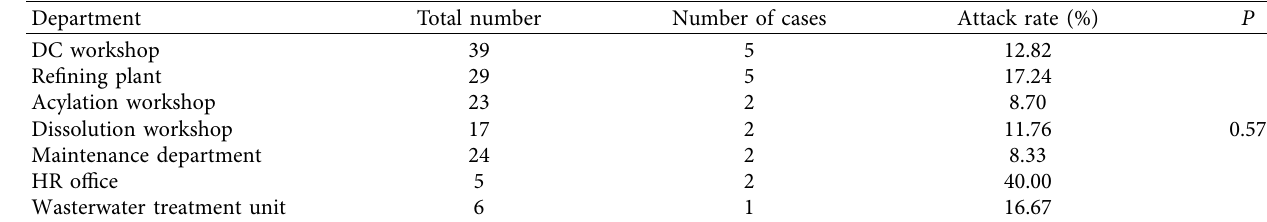
Table 2: Comparison of attack rates in different departments.